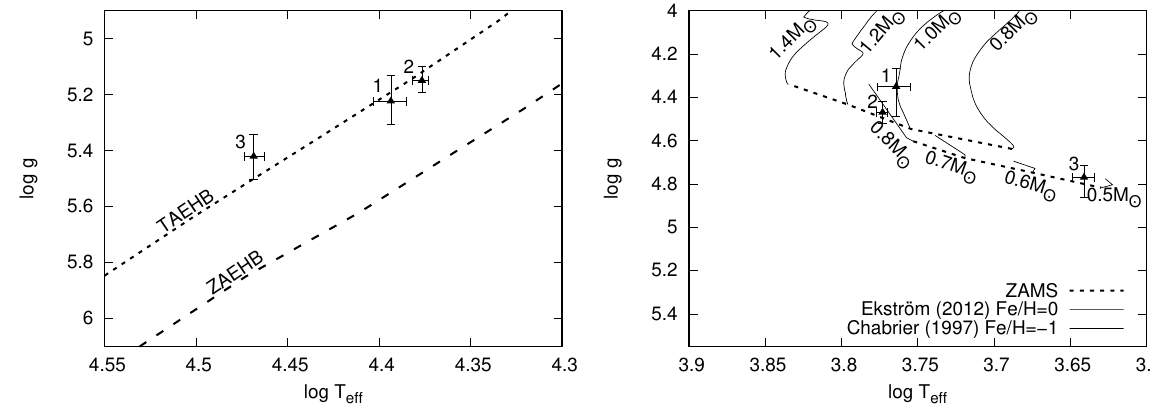
Figure 2. Left: : Fitted parameter of the hot subdwarf of three candidates (1: SDSS J083350+110104, 2: SDSS J161943+240716, 3: SDSS J215054+131651) from the SDSS sample, overplotted with zero and terminal age extreme horizontal branch (ZAEHB and TAEHB, respectively) tracks from Dorman et al. (1993). The sdB primaries lie close to the TAEHB. Right: Fitted parameters of the cool companion of the same can- didates from the SDSS sample, overplotted with the evolutionary tracks from Chabrier & Baraffe (1997) (sub-solar metalicity) and Ekström et al. (2012) (solar